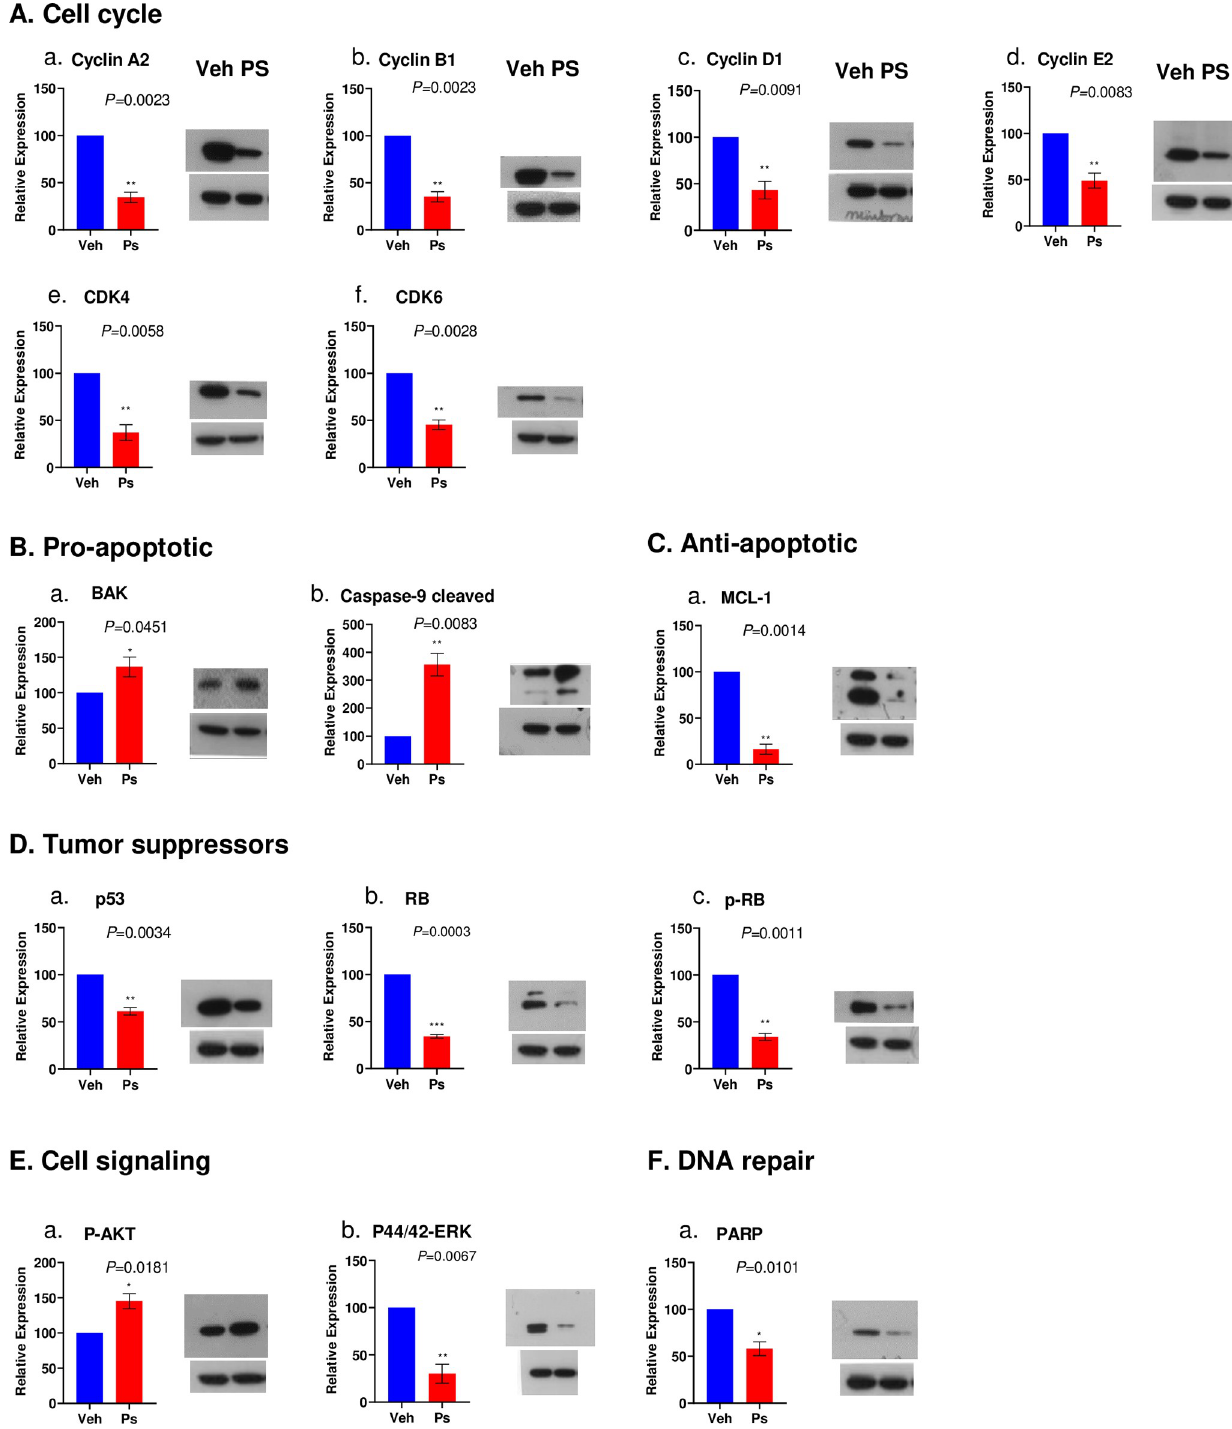
Fig 5. Protein expression in CCL235 cells. Proteins implicated in various cellular functions as indicated, measured in cells treated with psiadin (PS) or vehicle control (Veh). Protein extracts were electrophoresed on polyacrylamide gels, electroblotted onto PVDF membranes and incubated with appropriate primary antibodies, followed by secondary antibodies and visualized by autoradiography with ECL reagents as described in Methods. Example blot is shown for each target protein with loading control actin under it; histogram shows densitometric quantification for 3 determinations (mean ± SD) normalized to actin and with Veh set at